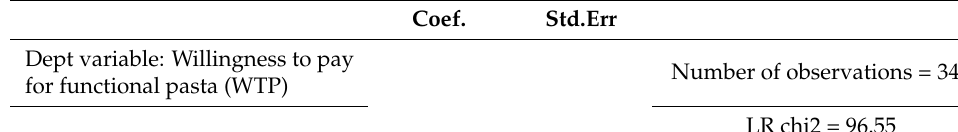
Table 4. Results of the ordered logistic regression